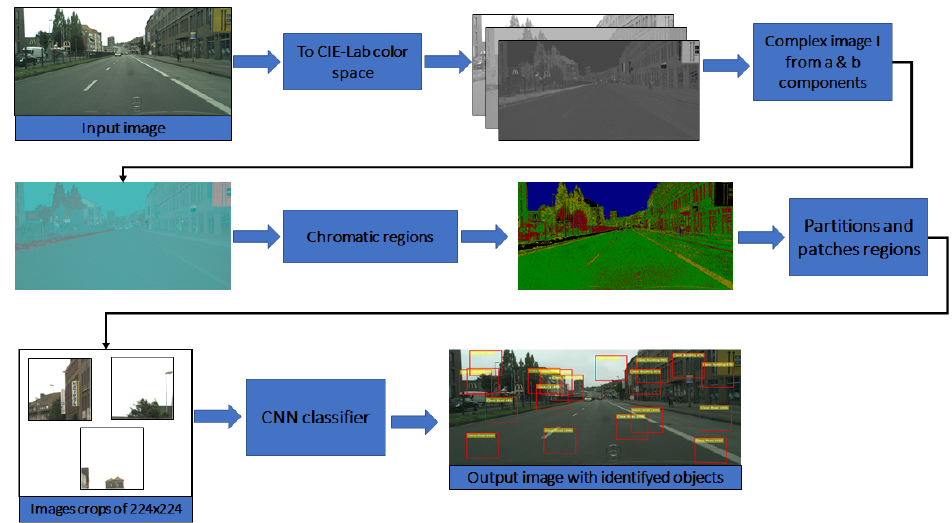
Figure 1. Proposed segmentation method to identify objects.